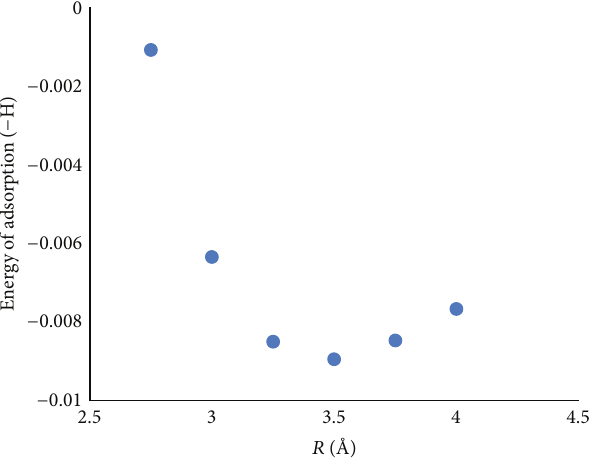
Figure 3: Potential energy diagram for NO- ( WO 3 ) 2 system.